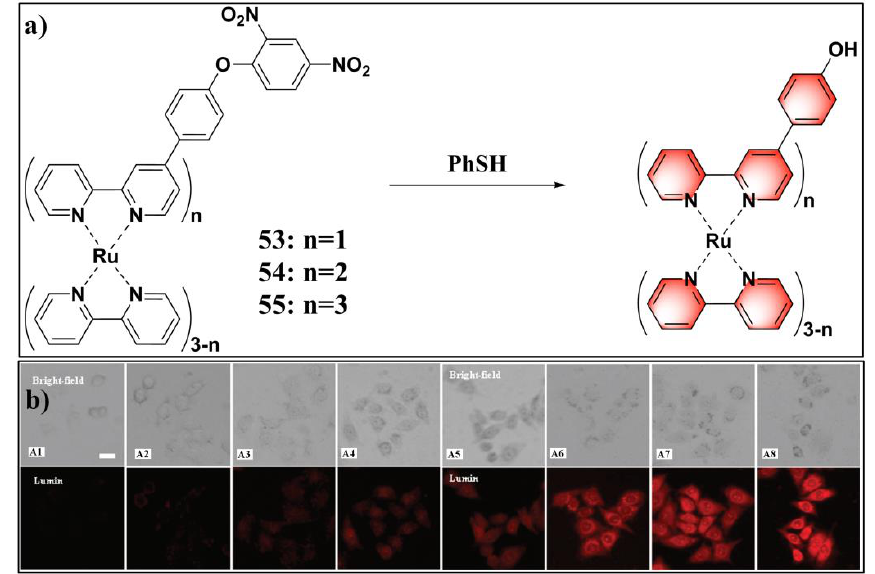
Figure 22. ( a ) Structure and reaction of probes 53–55 with PhSH. (b) Images of 54 -loaded Hela cells incubated with PhSH for di ff erent times, from A1 to A8 (0, 5, 10, 20, 30, 40, 50, 60 min); scale bar: 10 µ m. incubated with PhSH for different times, from A1 to A8 (0, 5, 10, 20, 30, 40, 50, 60 min); scale bar: 10 Reproduced with permission from Reference [131]; copyright American Chemical μm. Reproduced with permission from Reference [131]; copyright American Chemical Society.